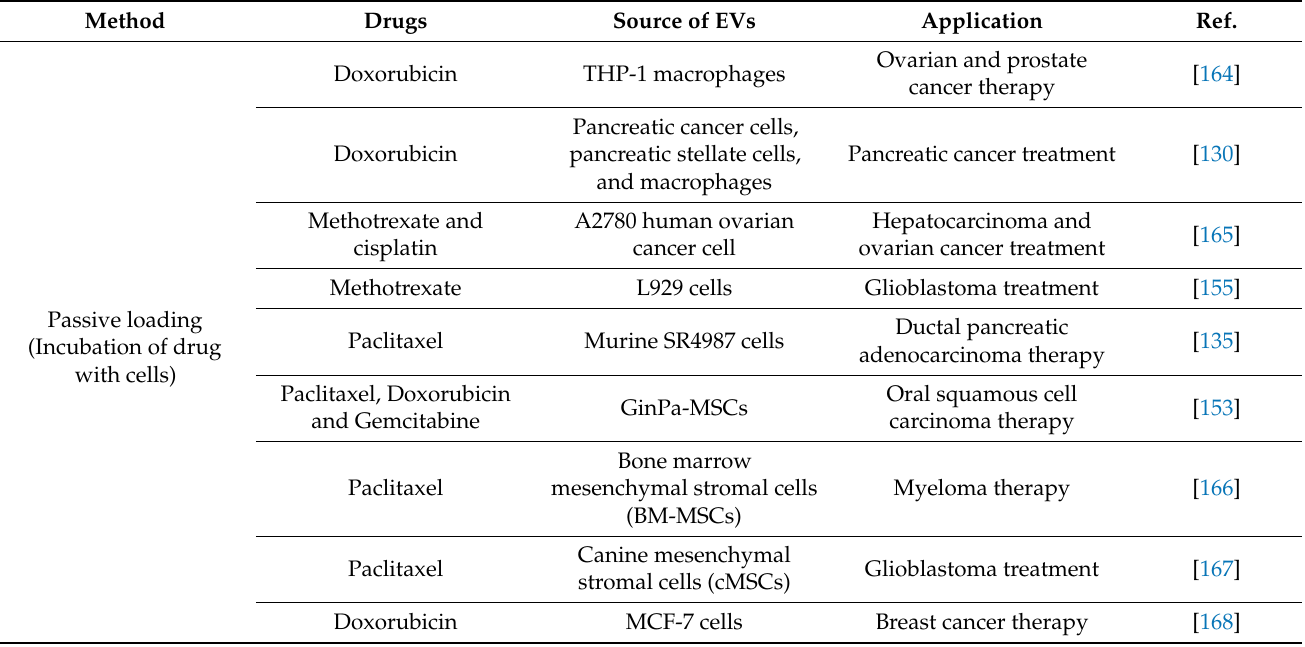
Table 1. Different strategies of drug loading into EVs for cancer therapy.